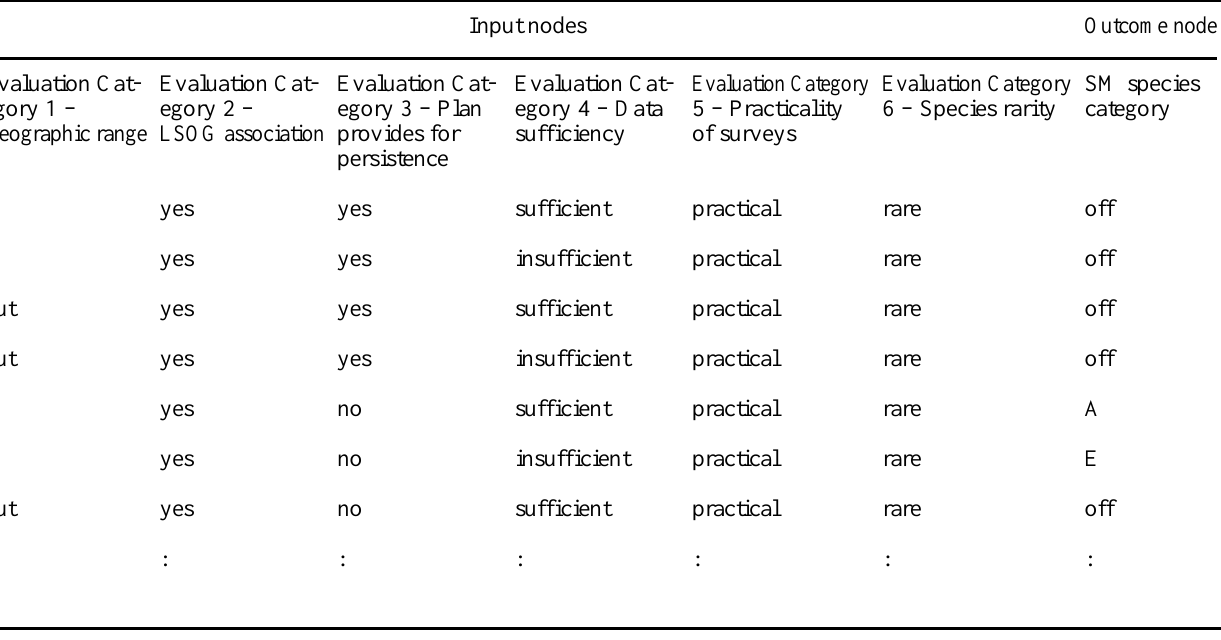
Table 3. Conditional probability table for the outcome node “SM species category” shown in the overall decision model in Fig. 1. See text for explanation of evaluation categories and SM species outcome categories. LSOG = late-successional and old-growth forest. Shown here is only a portion of the very long